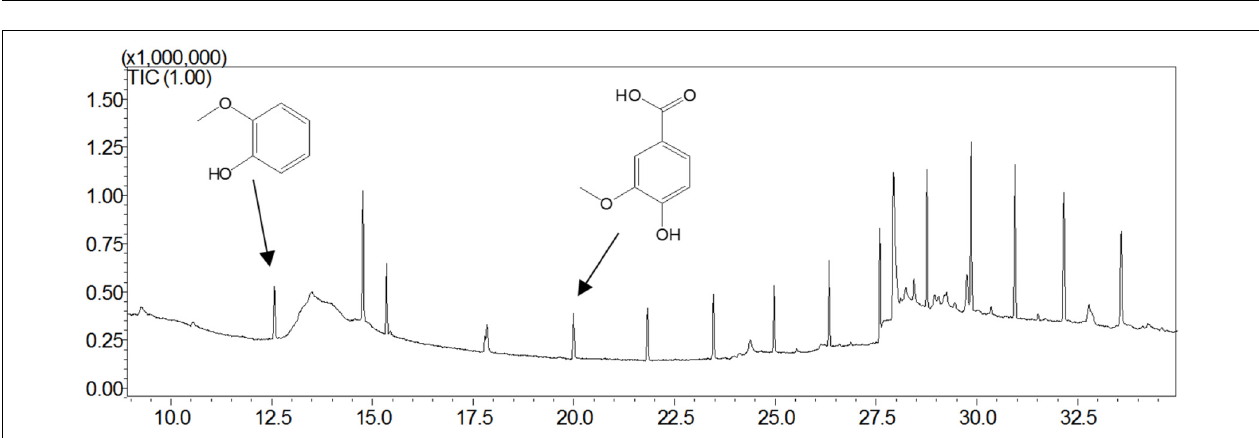
Frontiers in Microbiology |